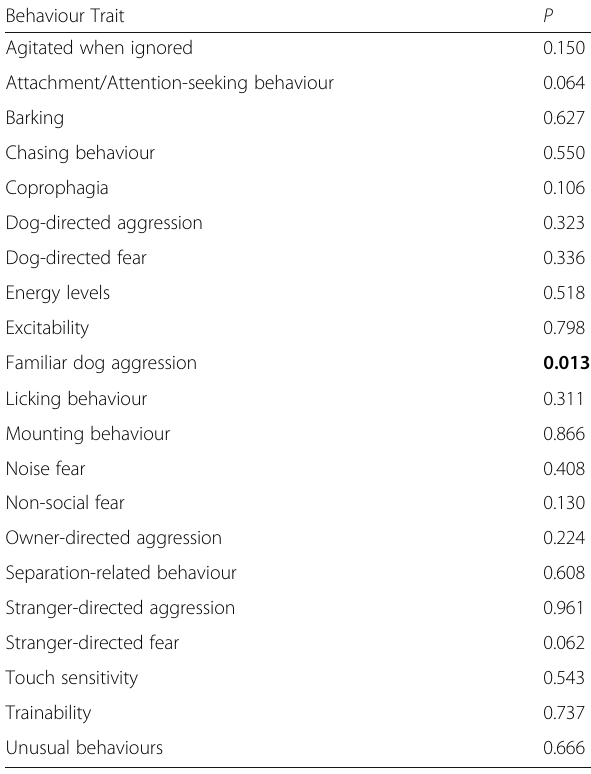
P : chi-square probability using Kruskal-Wallis nonparametric test to compare black, yellow and chocolate Labradors Probability in bold typeface indicates P